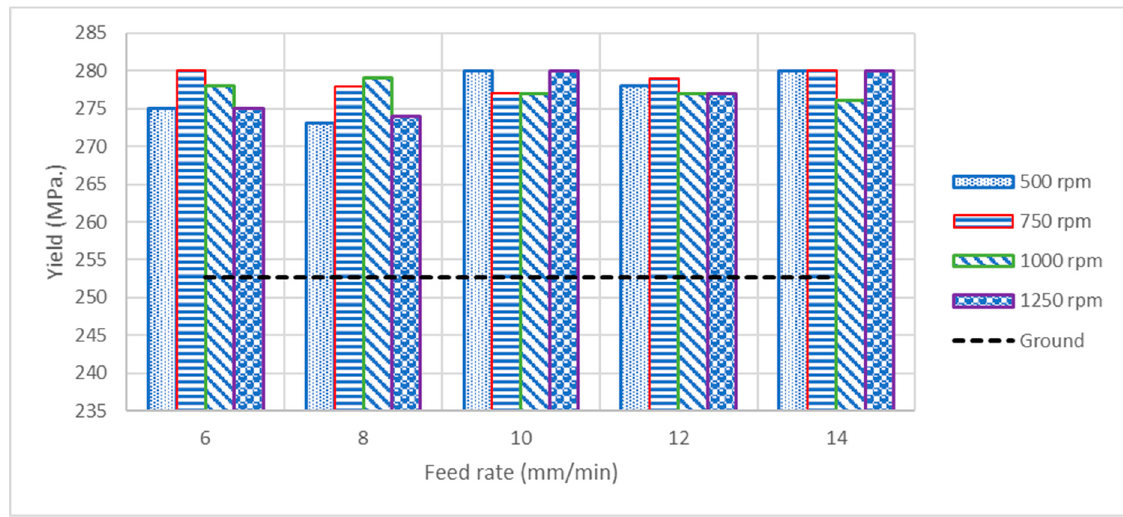
Figure 5. Bar chart of yield strength for various hardening speeds and feed rates. The root mean square height (Sq) and arithmetic mean height (Sa) were evaluated for the ground and surface-hardened samples, as shown in Figure 6. The results show that Sq is higher for all speed–feed rate combinations than for the ground sample. The Sq values of the ground and the optimum surface-hardened samples were 10.5 μ m and 27 μ m, respectively. The Sa values for the ground and best surface hardening condition samples were 1.1 μ m and 3.3 μ m, respectively. The high values of roughness are due to the high indentation marks of the stainless steel balls on the brass surface, oscillations of balls, and friction, causing its surface to plastically deform, as shown in Figure 3. We notice that surface roughness is not affected mainly by rotational speed, while roughness at both low and high feed rates (6 and 14 mm min − 1 ) shows better Sa and Sq values than the other feed rates. At a low feed rate, more surface area is work-hardened with compressive forces exerted by the balls in the MSWH process. However, at a high feed rate, more friction effects are exerted on the treated surface. Therefore, the feed rate and its combinations with the processing speed contribute to changing the surface roughness.